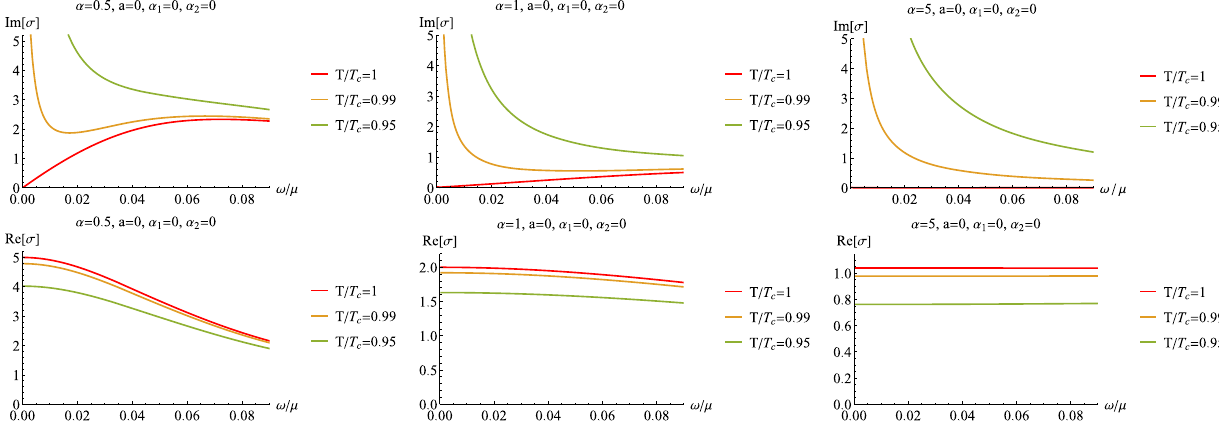
Fig. 5 The conductivities σ as a function of the frequency for different α fixing a = 0, α 1 = 0, and α 2 = 0. The left panels are for the real part and the right panels are for the imaginary one. Here we have abbreviated the two dimensionless quantities { T /μ,α/μ } to { T ,α }